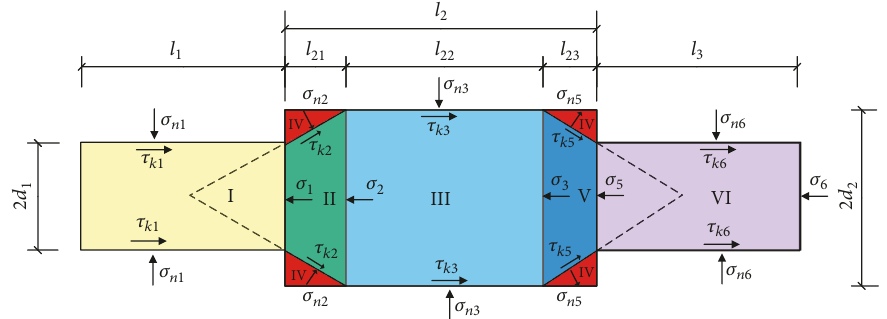
Figure 6: Stress diagram of lead in forward compressive state.